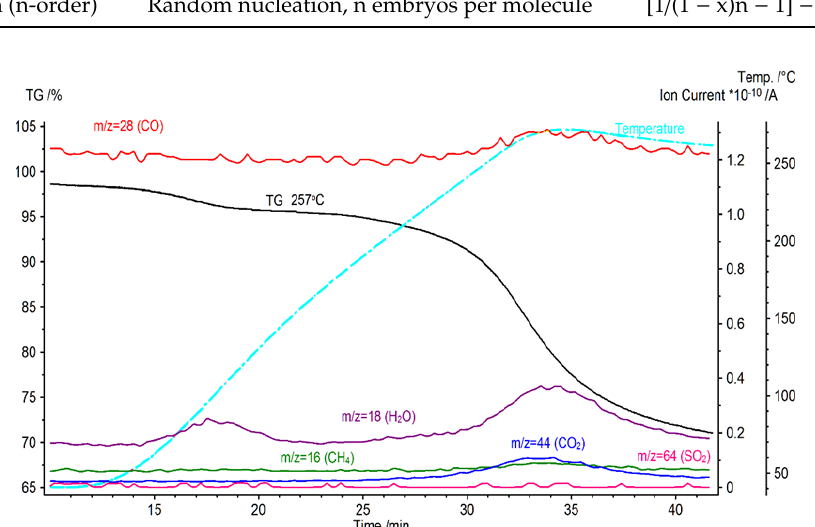
Figure A7. TG curve and ion current curves for the maize straw torrefaction process carried out up to 257.5 °C.